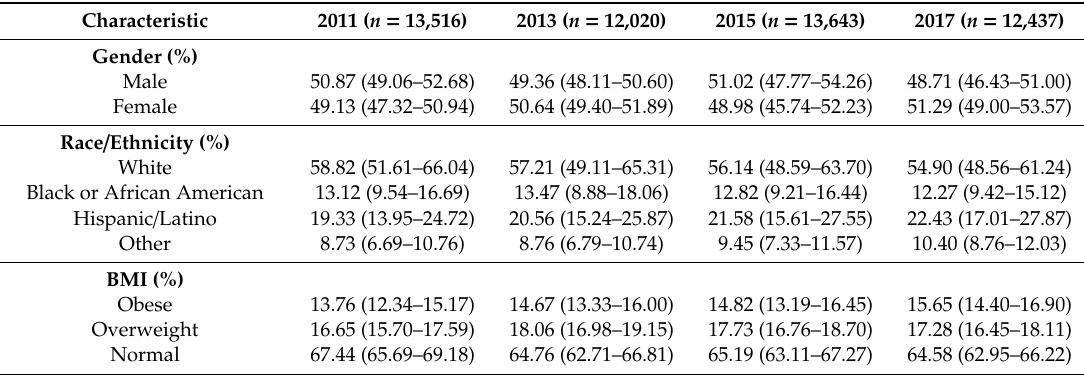
Table 1. Weighted prevalence of demographic characteristics across the evaluated cycles (2011–2017 YRBSS; N = 51616) a